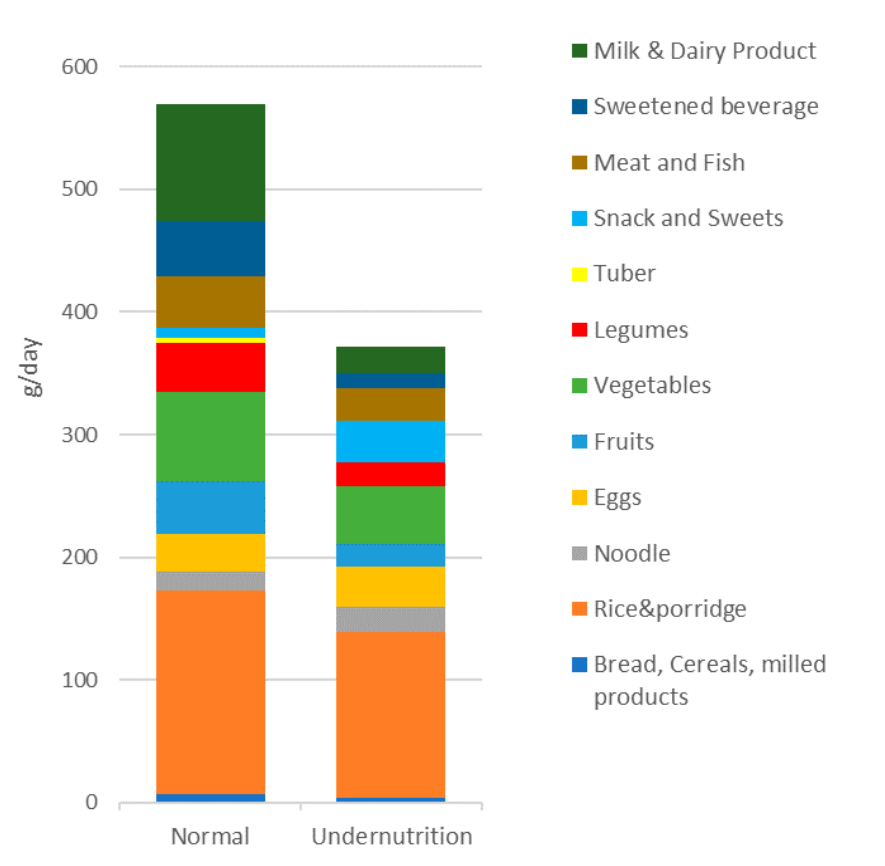
Figure 1. The amount of food consumed per day. The gut microbiota between normal and undernutrition was defined by sequencing the V3-V4 region’s 16S rRNA gene. A total read number of 612,159 was obtained from 28 samples, with 21,862.821 ± 4928.863 reads per sample (min–max: 13,951–33,229) re- sulting 361 OTUs. In total, 11 phyla, 40 families, and 72 genera were detected.